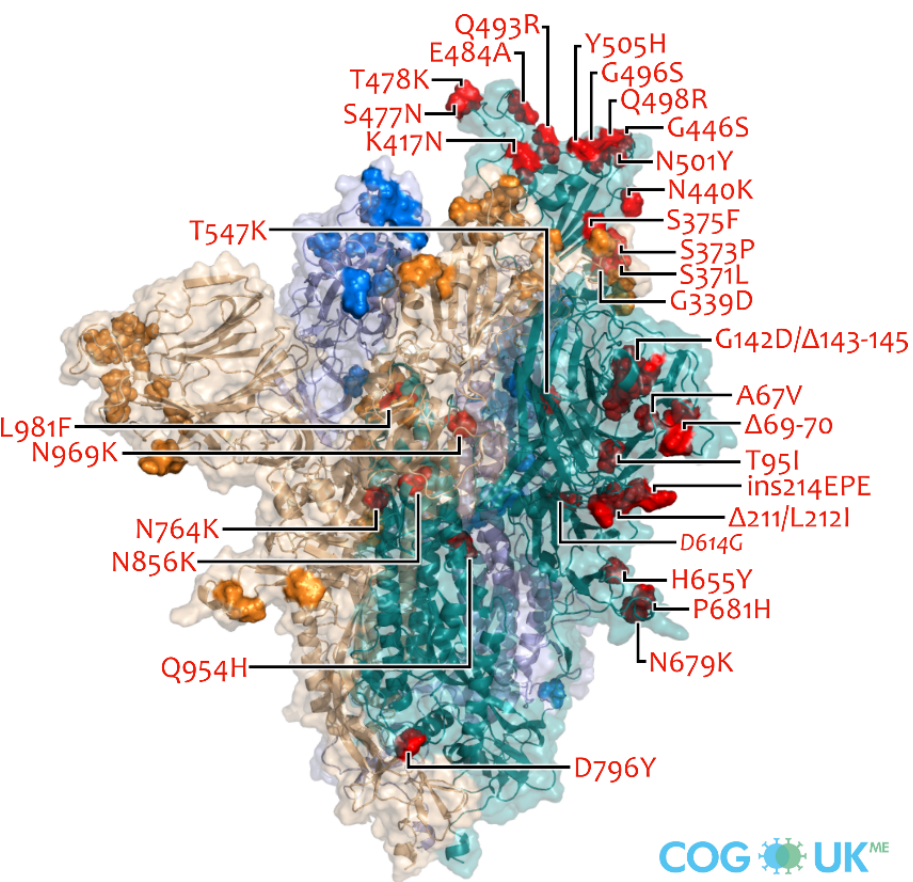
Figure 4. Omicron variant spike protein mutations (MRC-University of Glasgow Centre for Virus Research) (https://sars2.cvr.gla.ac.uk/cog-uk/mutants_BA.1_ME_web.png; accessed on 31 January 2022).